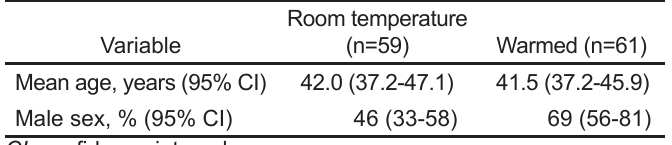
Table 1. Patient characteristics.